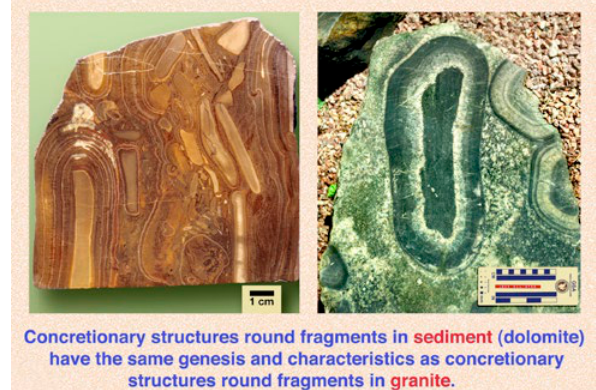
Figure 22. Geologists know that natural sediments like marine mud, lime mud and dolomite are diffusive gelatinous or ‘sticky’ materials. Orbicules can then form round a synerectic fragment like in this example from Gunpowder Creek in NW Queensland. The formation of an orbicule round a schist fragment in the orbicu- lar granite from Kangasniemi in Finland is clear evidence that the granite crystallised from a diffusive gelatinous precursor.